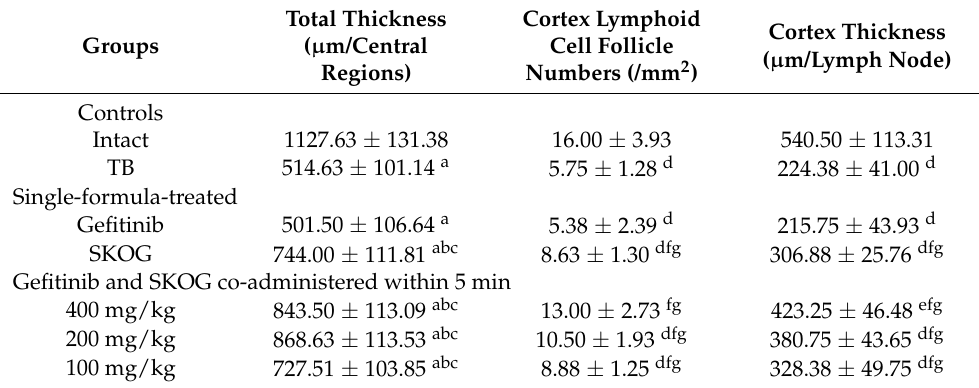
Table 8. Changes in the submandibular lymph node histomorphometry of NCI-H520 tumor cell xenograft